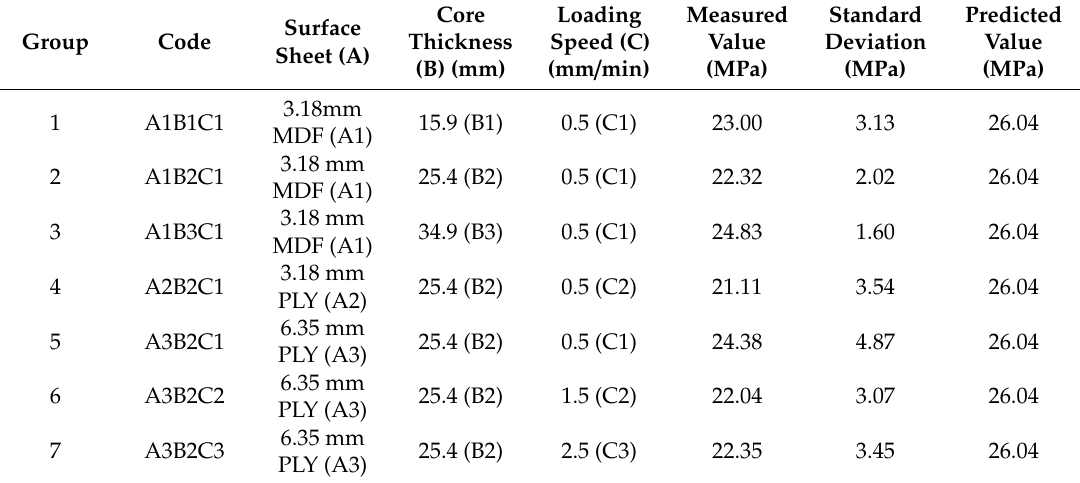
Table 5. Predicted modulus derived by the cell wall characteristicsand measured results of the sandwich structure under transverse